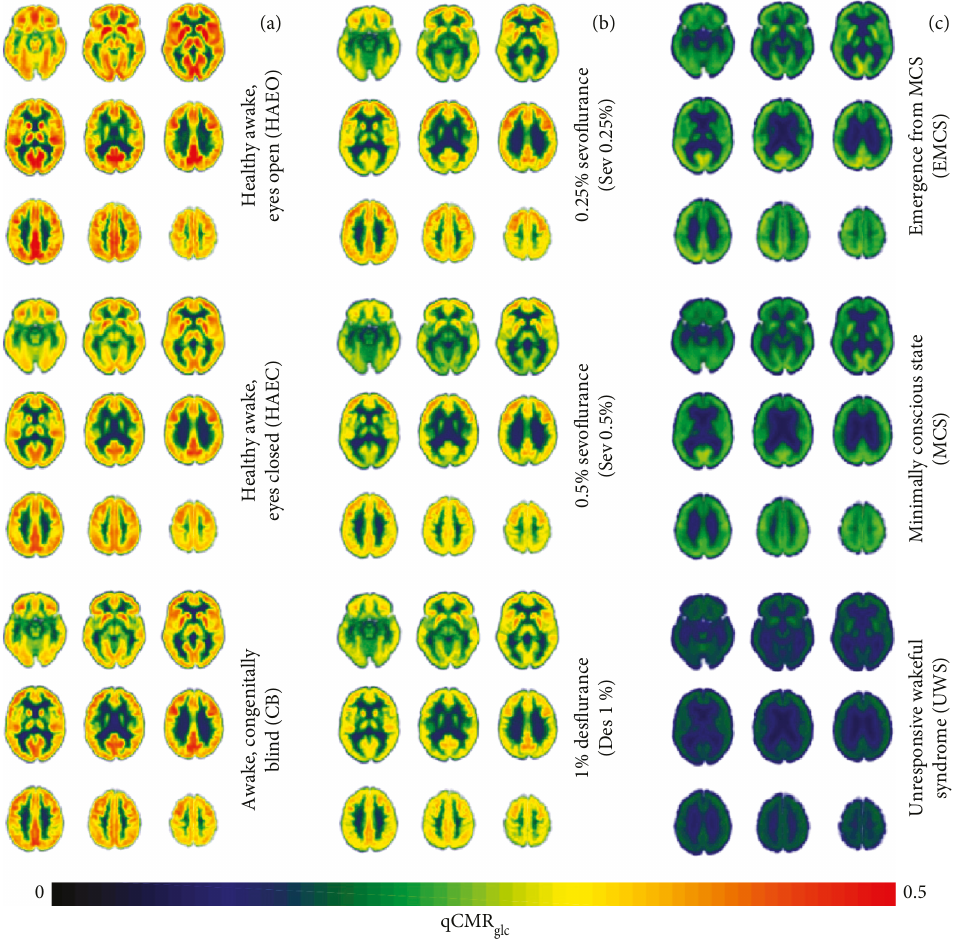
Figure 2: Quanti fi ed CMR (qCMR ) maps of the human brain across nine di ff erent states (Table 1), which are (a) healthy awake sighted glc glc people with eyes closed (HAEC) or with eyes open (HAEO), as well as healthy awake people who are congenitally blind (CB), (b) healthy people under sedation with gaseous anesthetics (i.e., 0.25% sevo fl urane (Sev0.25%), 0.5% sevo fl urane (Sev0.5%), and 1% des fl urane (Des1%)), and (c) patients with disorders of consciousness (i.e., unresponsive wakefulness syndrome (UWS), minimally conscious state (MCS), and emergence from minimally conscious state (EMCS)). Global increases in qCMR were observed proceeding from bottom to glc top in each column, which is in general agreement with prior PET studies [19, 45 – 50, 53]. The units are in μ mol/g/min. With HAEC as the control condition, all other groups (except the CB group) showed signi fi cant global di ff erences in gray matter (Figure S1) and white matter (Figure S2). These and all other images are in the coordinates of the MNI template: left column (from top to bottom) with z values of − 15 mm, − 12mm, and − 39mm; middle column (from top to bottom) with z values of − 6 mm, − 21mm, and − 48 mm; and right column (from top to bottom) with z values of − 3 mm, − 30mm, and −